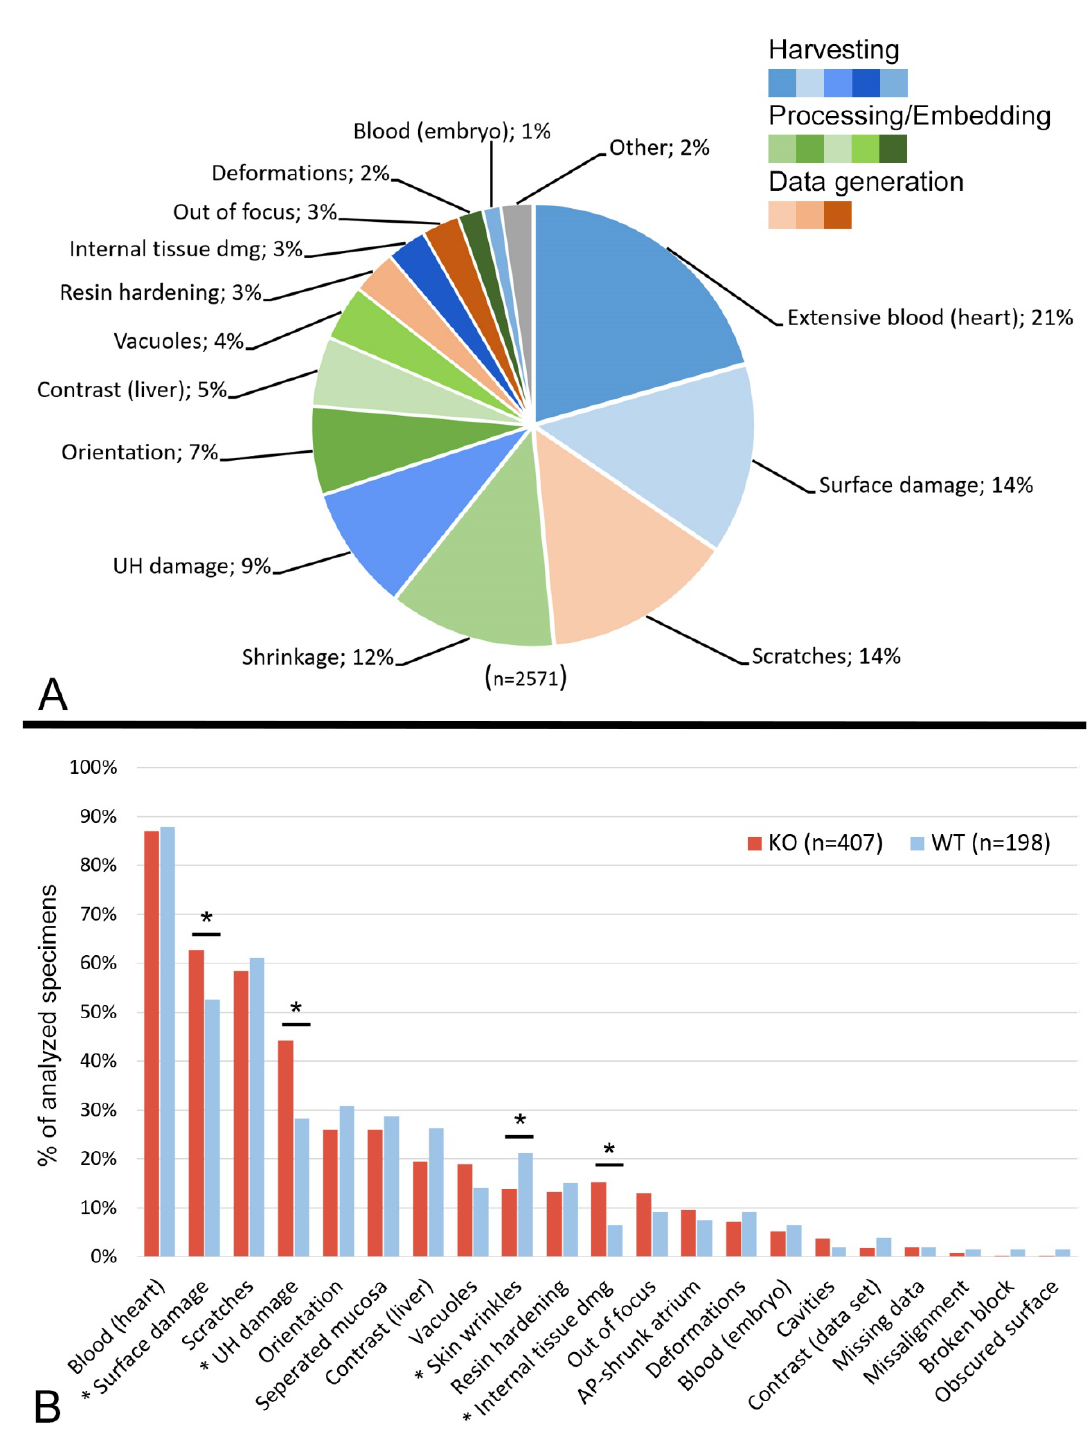
Figure 1. Frequency of artefacts. ( A ) Pie chart of artefact types relative to the total number of described artefacts. Harvesting artefacts in blue, processing/embedding artefacts in green, data generation artefacts in orange. “Shrinkage” includes extensive skin wrinkles, shrunk cardiac atrium and separated stomach mucosa; “UH damage” includes damaged and removed umbilical hernia and damaged intestinal slings; “Internal tissue damage” includes tissue damage with or without surface damage. ( B ) Bar graph of artefact types relative to total number of analyzed specimens, comparing wild type and mutants. Asterisk indicates artefact type with significant difference between KO and WT embryos (* p < 0.05). Abbreviations: AP: anterior-posterior; KO: knockout; WT: wildtype; UH: umbilical hernia.